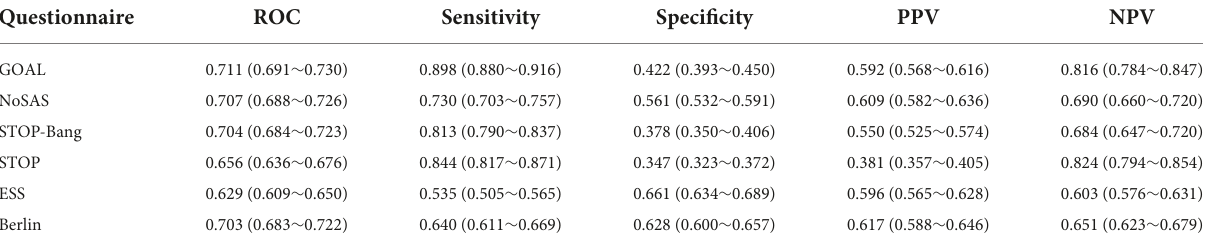
TABLE 3 Taking apnea hypopnea index (AHI) 15 as cut-off point for diagnosis of obstructive sleep apnea (OSA). Questionnaire